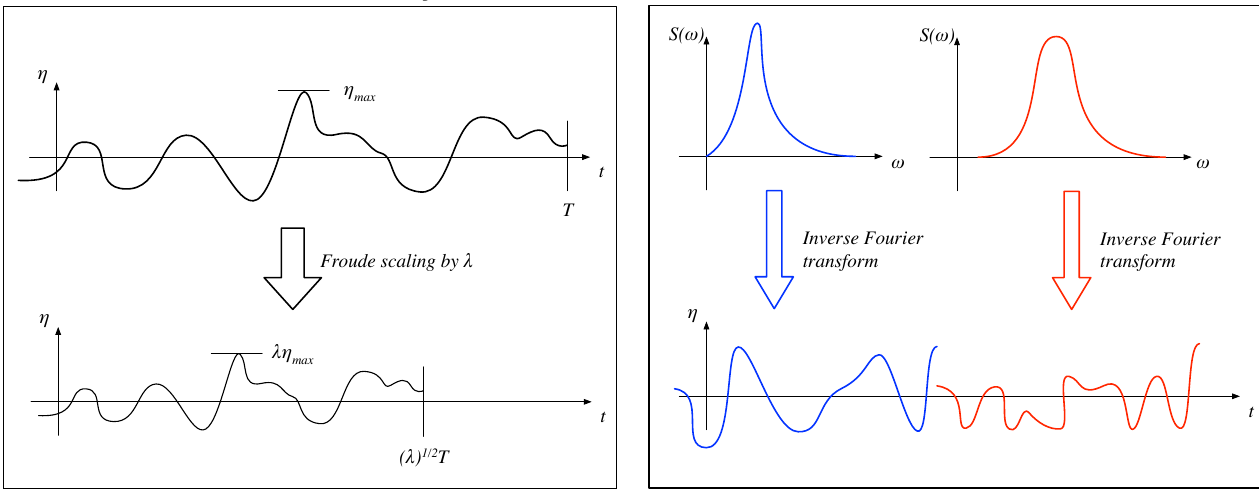
Fig. 5: Visualization of the procedure employed to create the scaled CDIP wave (a) and the approximation of an ‘instantaneous’ change in sea-state. Note that the discontinuity in the right plot time series exists only in the command to the wave maker: in reality, actuation limits at the wave maker and the physics of the basin ensure continuous dynamics that rapidly approximate the desired wave frequency